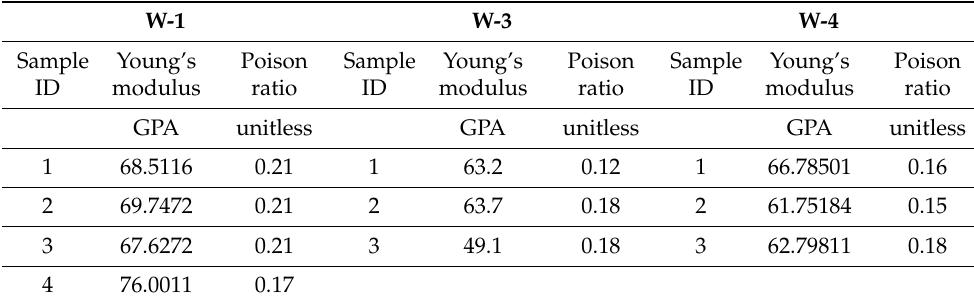
Table 1. Rock mechanical parameter testing in wells W-1, W-3, and